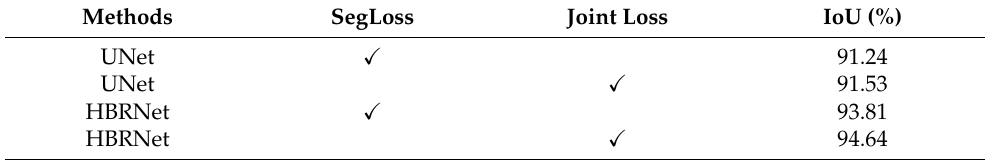
Table 4. Comparison of performance by only SegLoss and the Joint Loss; the difference is whether BR module was employed in UNet or HBRNet. (cid:88) means the corresponding component is